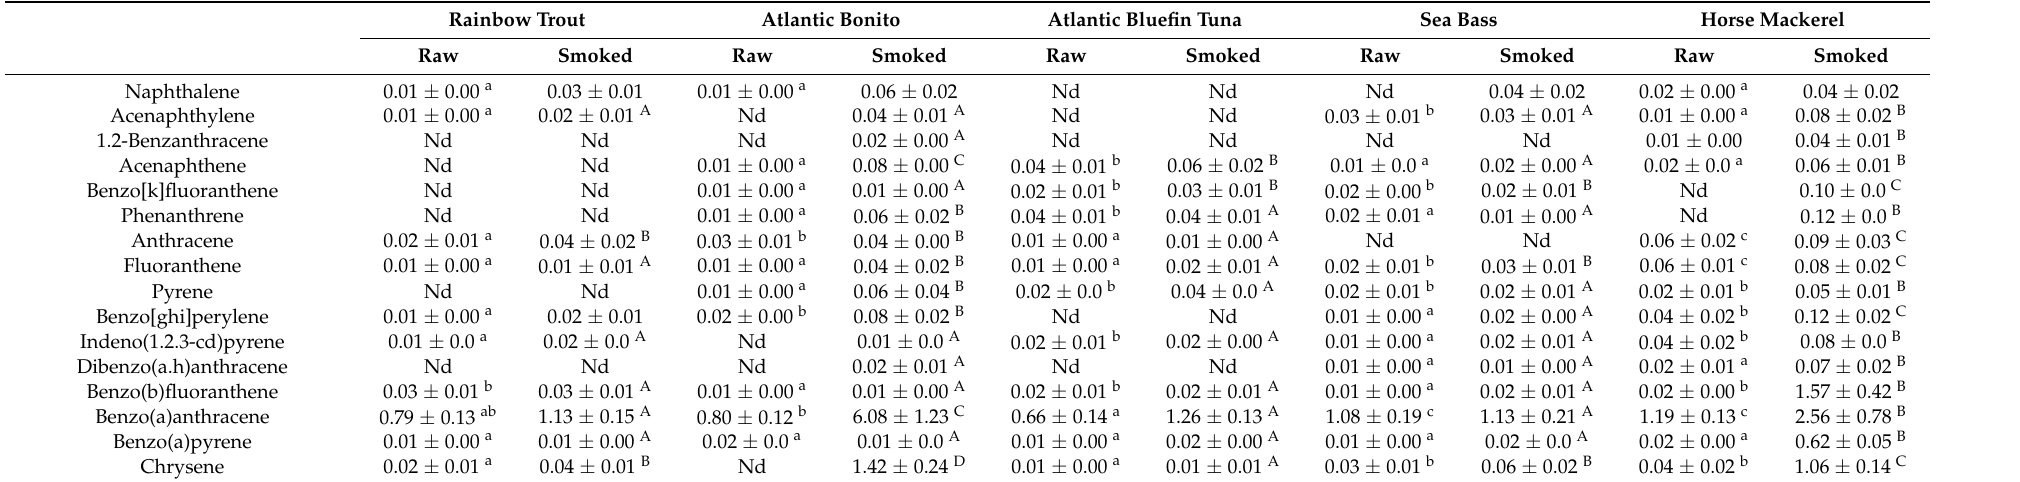
Table 3. Polycyclic aromatic hydrocarbons contents of raw and smoked fish samples ( µ g/kg). Rainbow